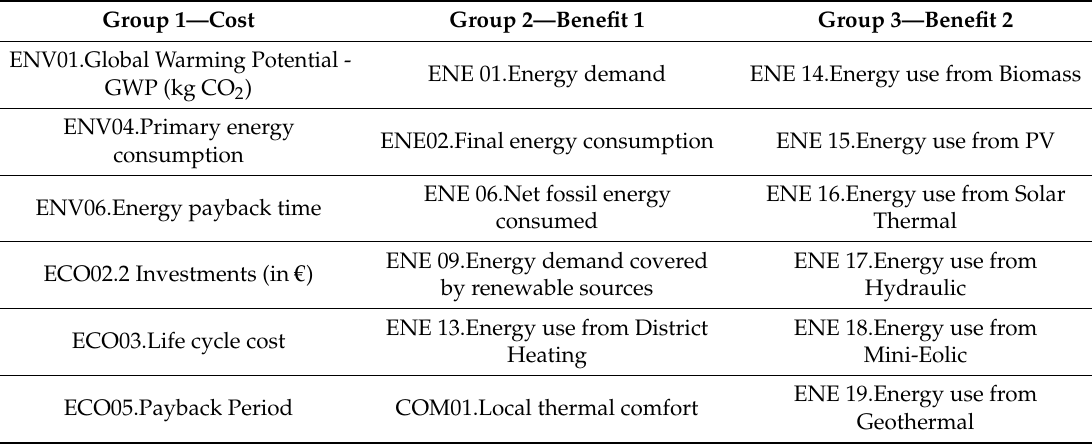
Table 1. List of District Performance Indicators (DPIs) per evaluation